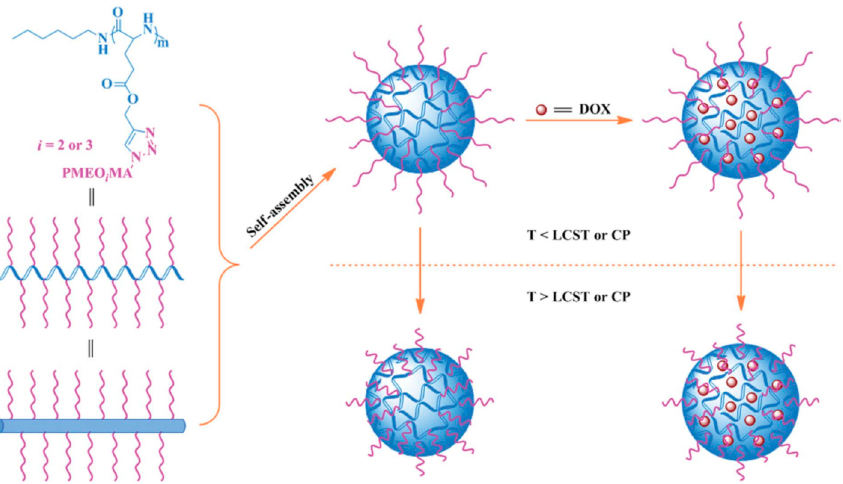
Figure 9. Self-assembly of “hairy-rod” polypeptides, DOX loading and responsiveness to thermal stimuli [32].